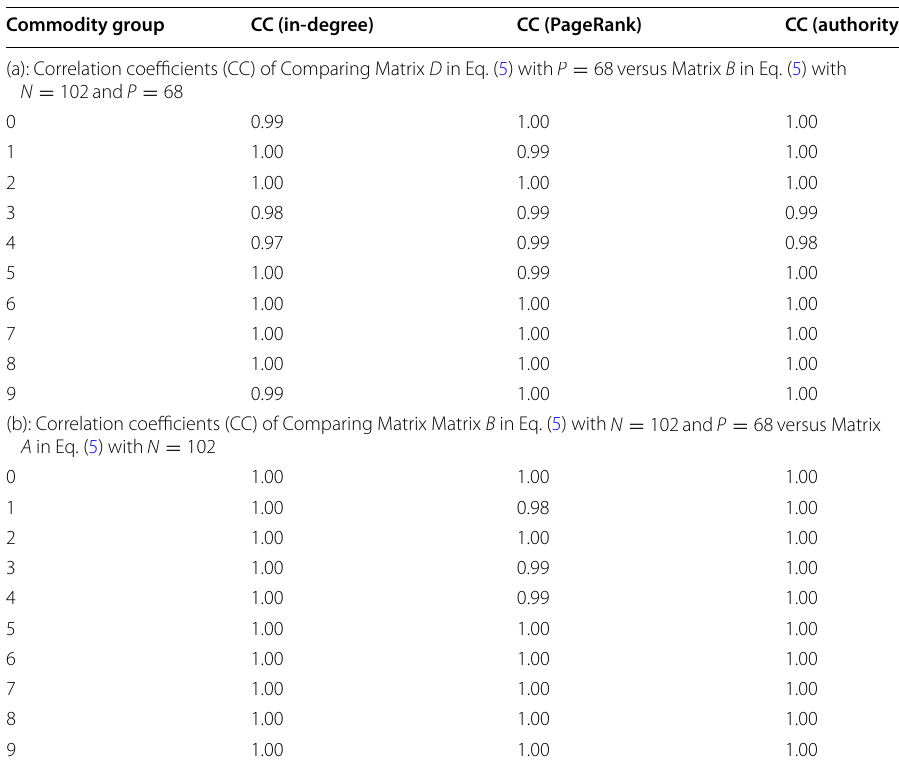
Table 8 Correlation coefficients between the rank of 102 countries in full 102-country network and reduced 102-country network [part (a)], and correlation coefficients between the rank of 68 countries in reduced 102-country network and the 68-country network [part (b)], based on centrality measures in import